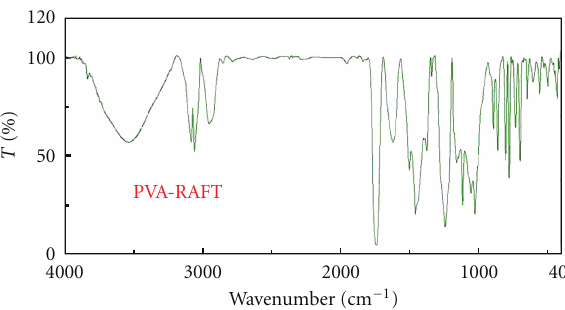
Figure 4: FTIR spectrums of PVA-RAFT.